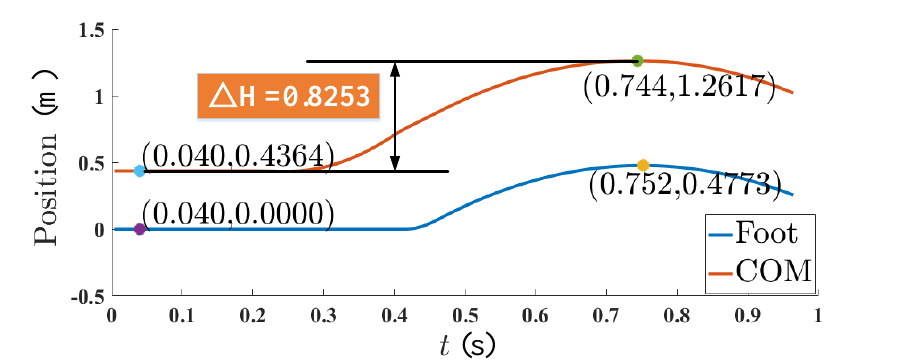
Figure 14. The foot and COM (center of mass) position in vertical direction in the